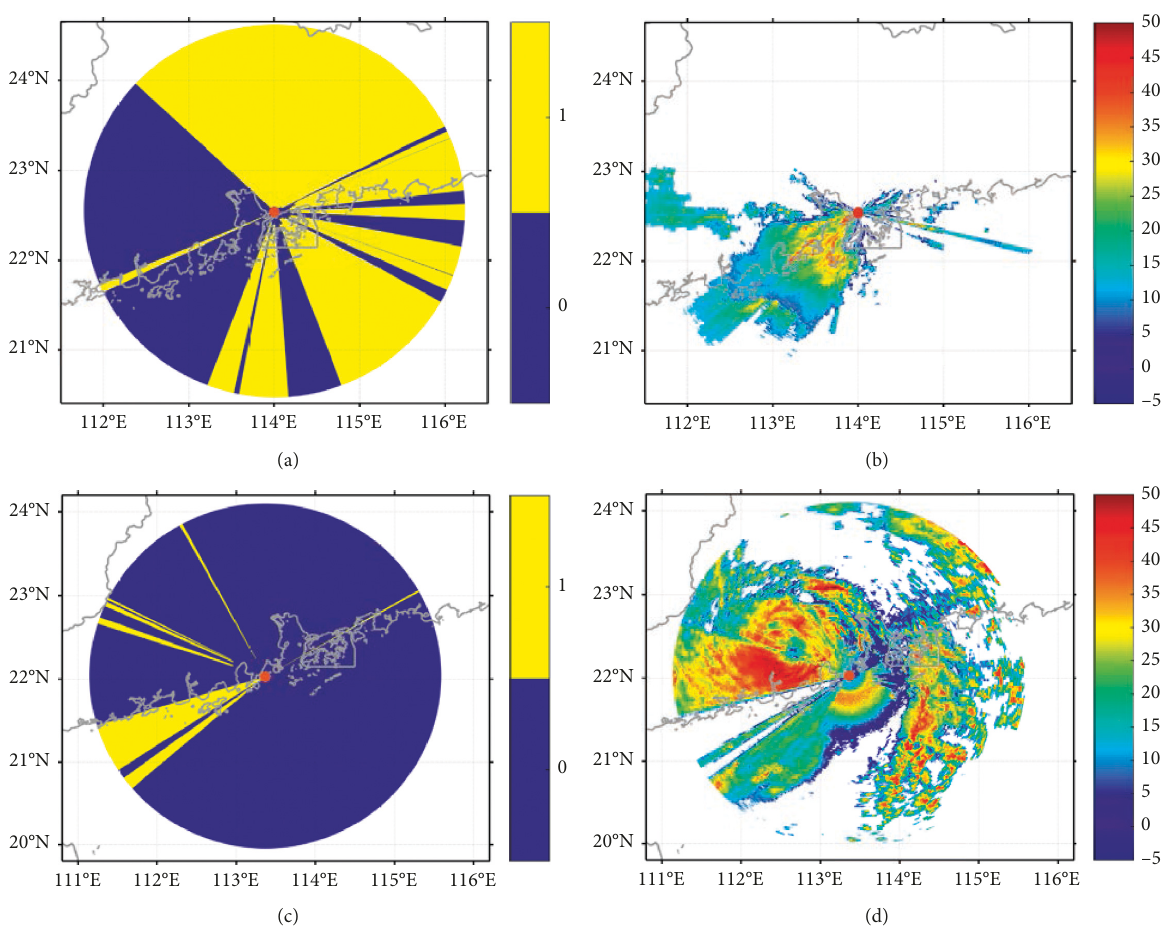
Figure 5: (a) The effective coverage map of Shenzhen radar using the first tilt (0.5 ° ) simulation, and the blue area denotes coverage area while the yellow area represents no radar coverage area. (b) The reflectivity at UTC 0000 4 September 2017 is used to validate the simulation result. (c) The effective coverage map of Zhuhai radar using the first tilt (0.5 ° ) simulation, and the blue area refers to coverage area while the yellow area indicates no radar coverage area. (d) The reflectivity at UTC 1512 23 August 2017 is used to validate the simulation result. The red dot corresponds to the radar